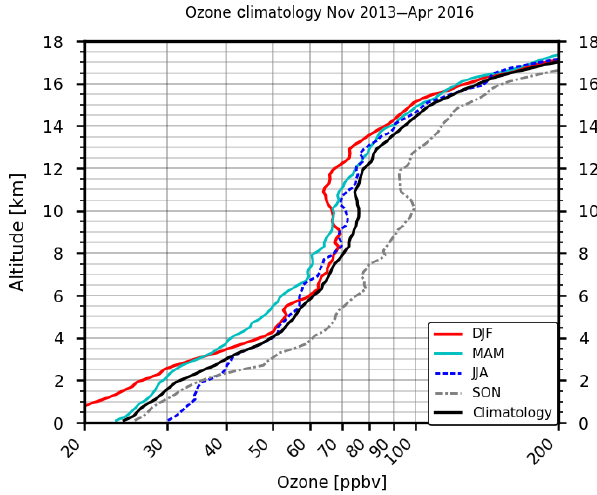
Figure 1. Climatological mean ozone profile (from November 2013 to April 2016) in black. The 2013–2016 seasonal mean ozone pro- file for summer (December, January, February) is in red, spring (March, April, May) is in cyan, winter (June, July, and August) is in blue and autumn (September, October, November) is in